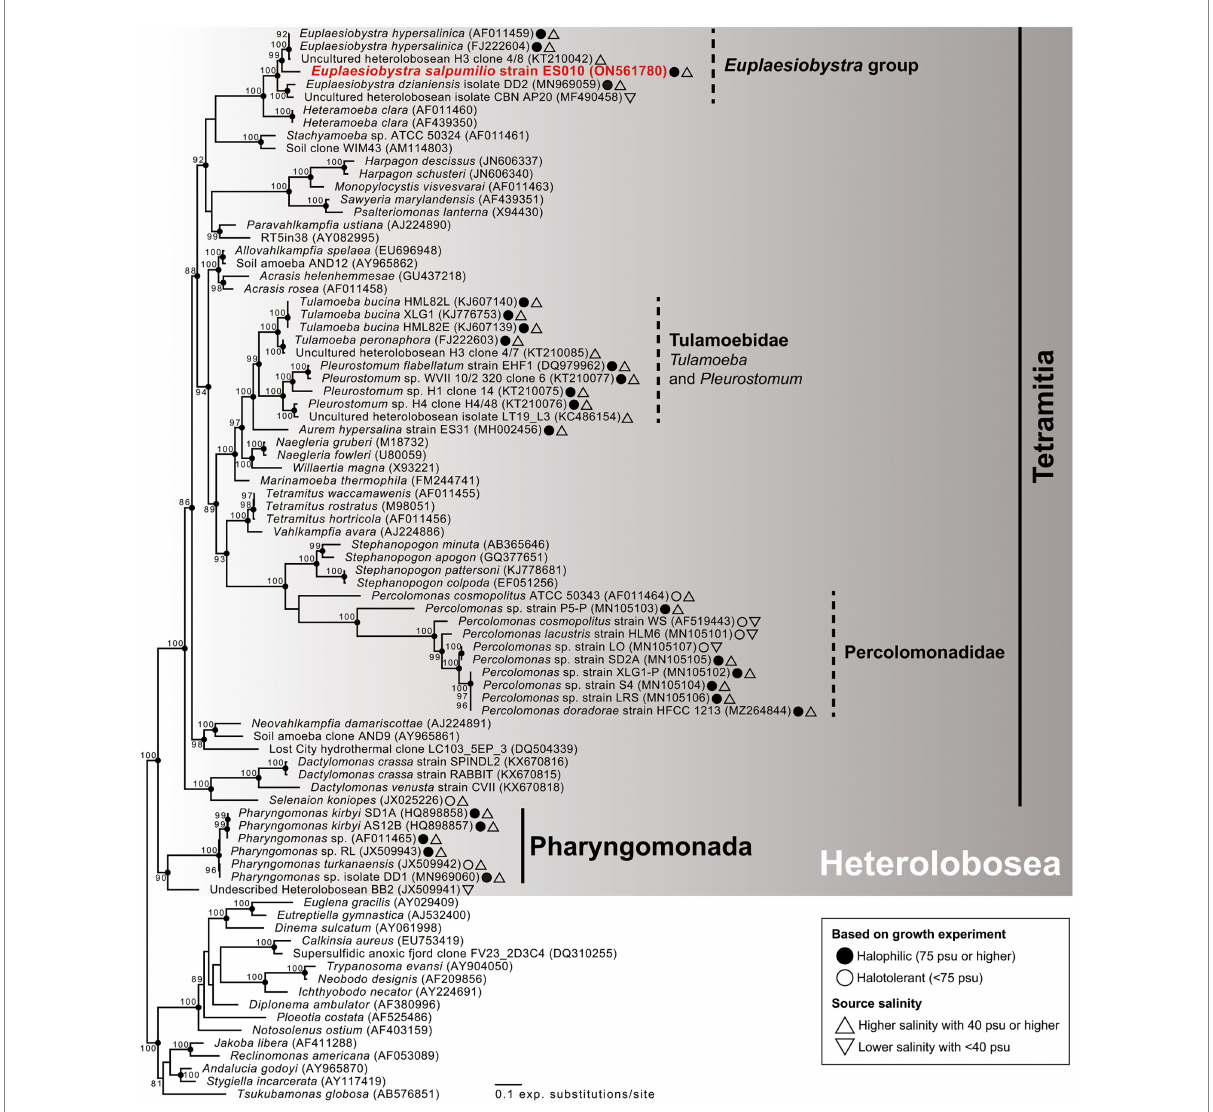
FIGURE 4 Maximum likelihood phylogenetic tree of 18S rRNA gene sequences showing the phylogenetic position of Euplaesiobystra salpumilio sp. nov. relative to 68 heterolobosean taxa and 16 species outgroups (i.e., Euglenozoa, Jakobida, and Tsukubamonas globosa ). Bootstrap support values (>80%) are shown at the nodes. Solid circles represent a Bayesian posterior probability of 1 (posterior probability <0.95 not